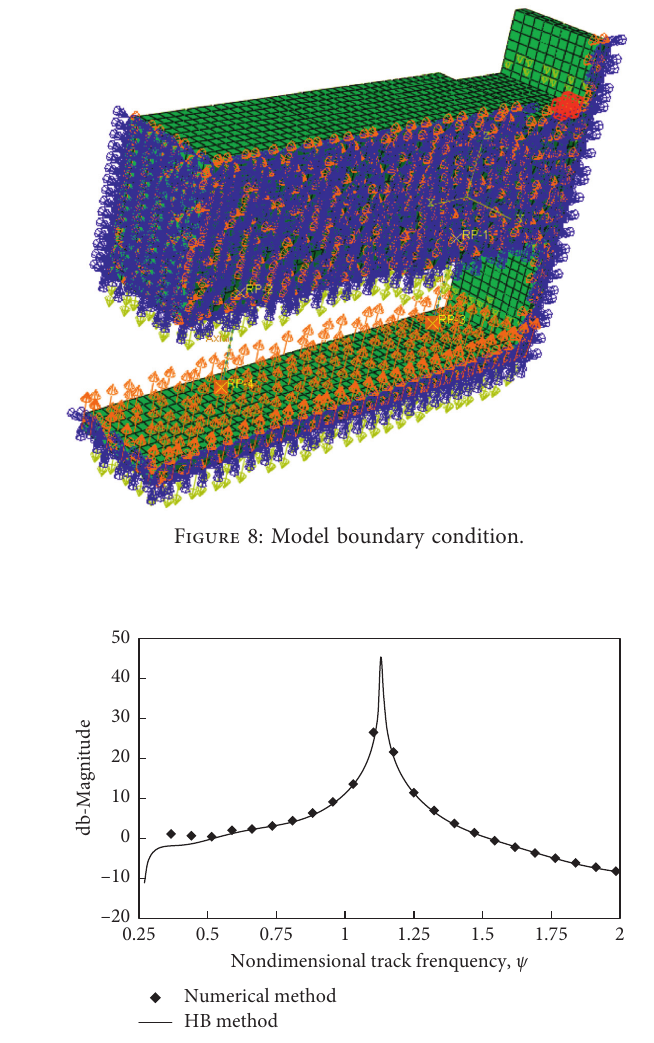
Figure 9: Results comparison when a � 11 . 14 for HB and numerical